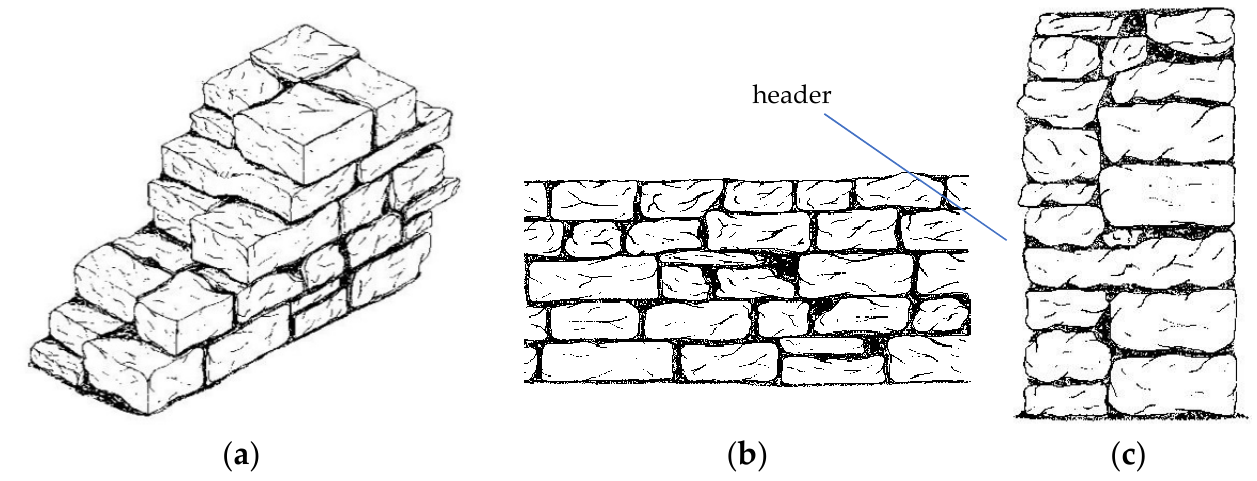
Figure 16. Sketches of a wall panel Type 1 (cross sectional thickness < 60 cm): ( a ) axonometric view, ( b ) front view, ( c ) wall cross section.